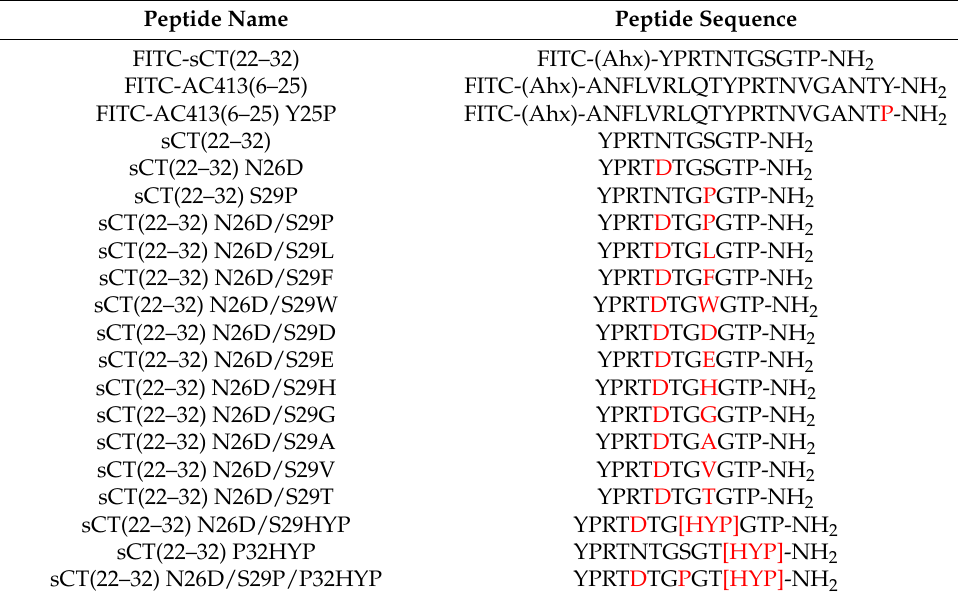
Table 1. Peptide sequences used in the current